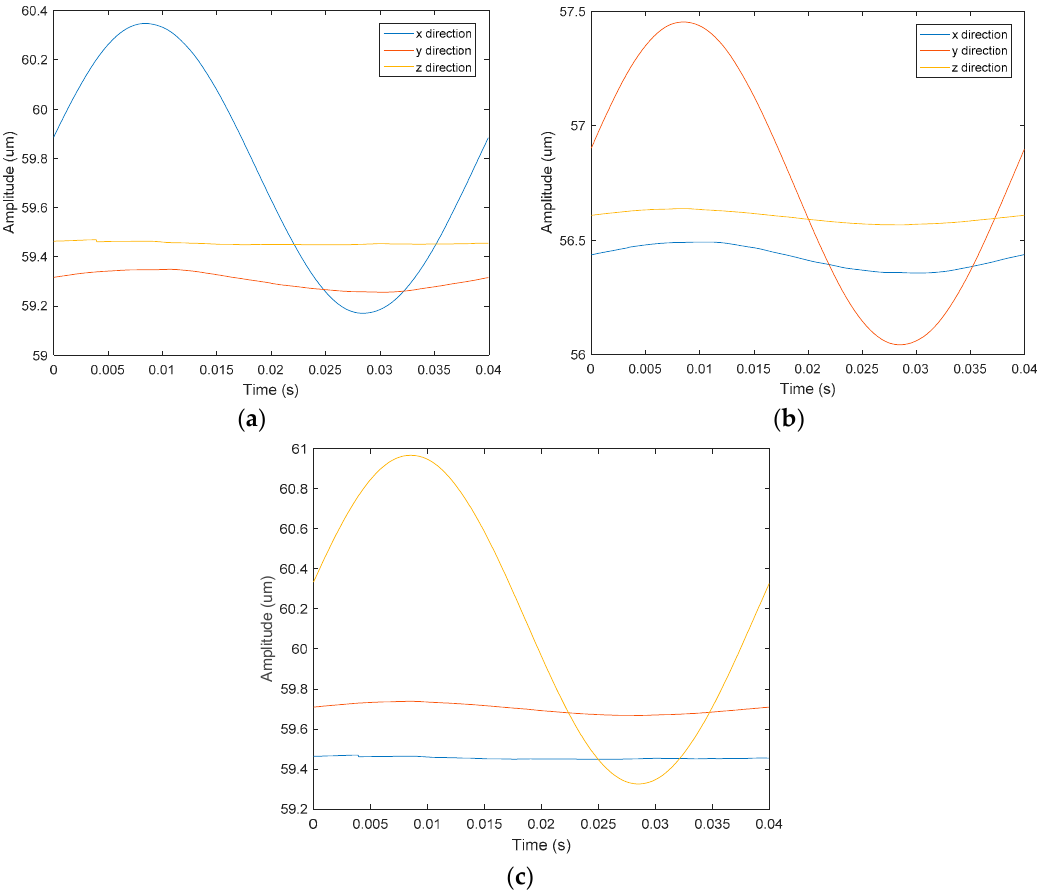
Figure 30. Time-amplitude diagram of linear motion performance test in each direction. ( a ) Driven in x direction; ( b ) driven in y direction; ( c ) driven in z direction.